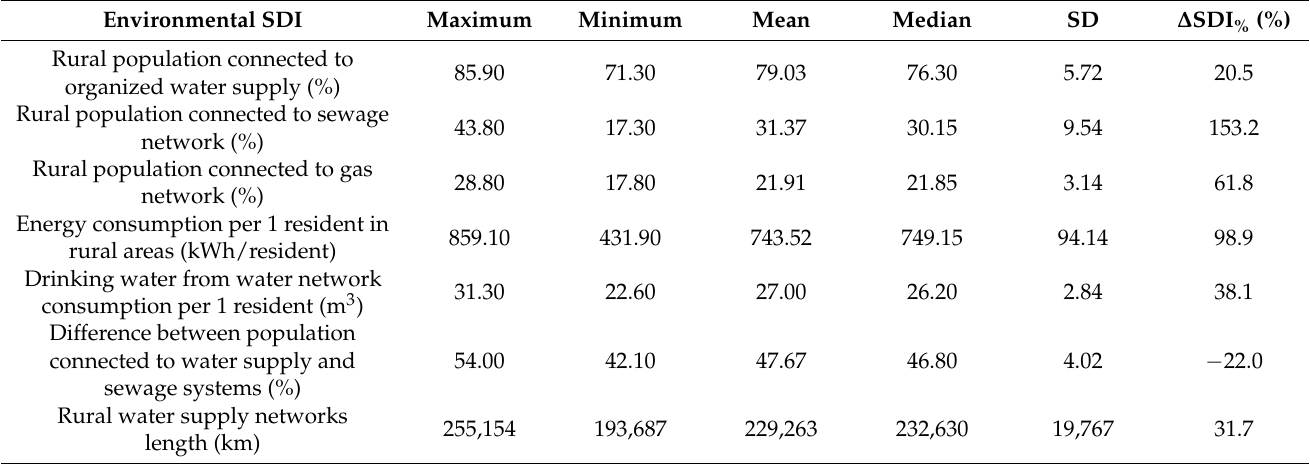
Table 2. Characteristics of environmental Sustainable Development Indicators used in the